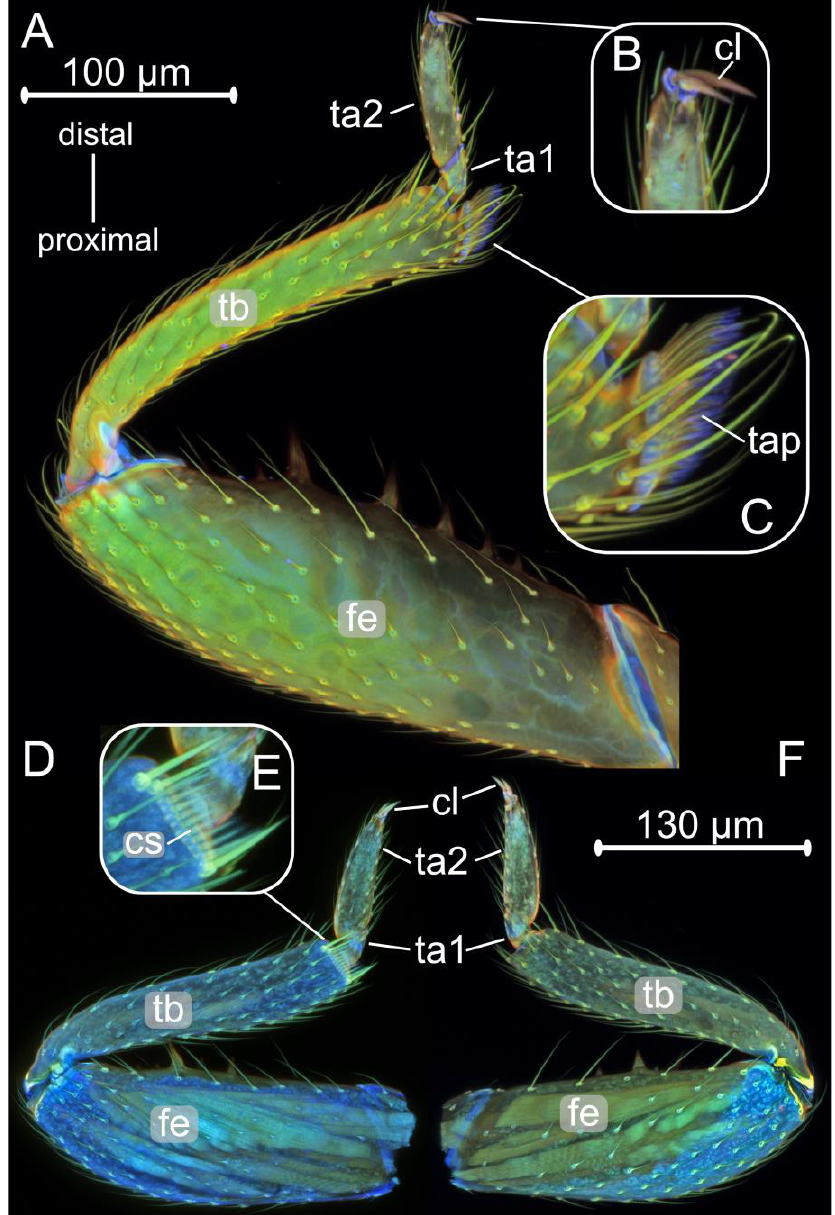
Figure 5. CLSM maximum intensity projections of Embiophila myersi. ( A – C ) Adult ( D – F ) nymph. ( A – C ) Prothoracic leg, anterodorsal view. ( B ) Claws. ( C ) Tibial adhesive pad. ( D , E ) Prothoracic leg, anterior view. ( E ) ‘Grooming’ setae ( F ) Prothoracic leg, posterior view. Abbreviation: cl — claw; cs — cleaning structure; fe — femur; ta — tarsomere; tap — tibial adhesive pad; tb — tibia.